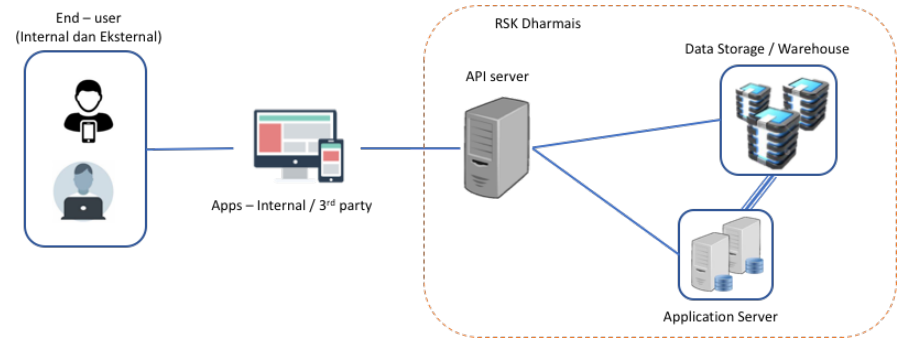
Figure 12. API diagram for Dharmais.